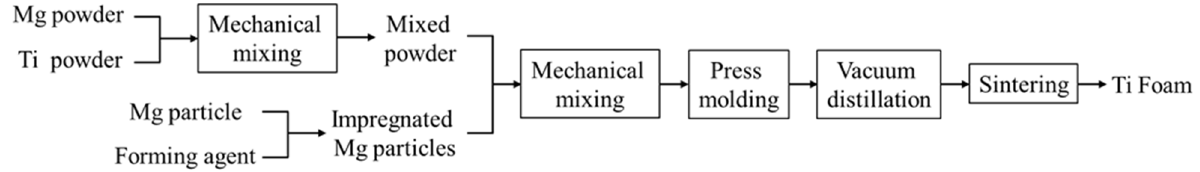
Figure 2. Process flow chart of preparing Ti foam by space holder method.